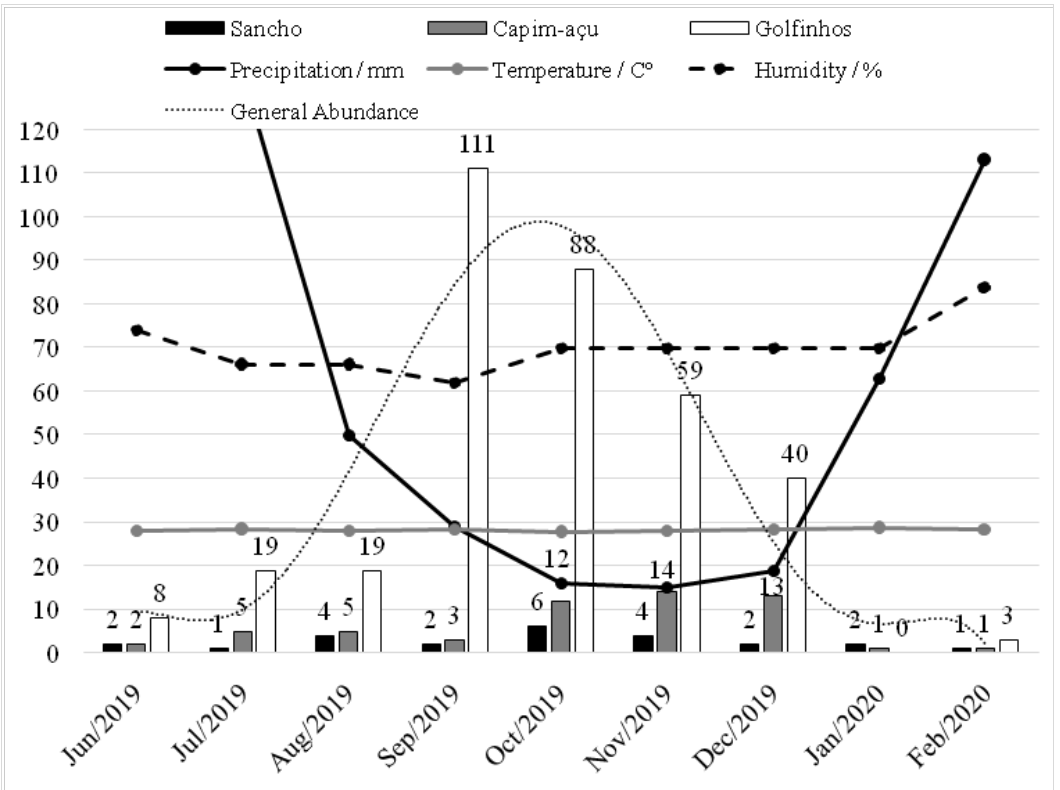
Fig 1 . Population fluctuation of Polistes ridleyi Kirby, 1890 in the archipelago of Fernando de Noronha over nine months of collection using flight interception traps ( Malaise